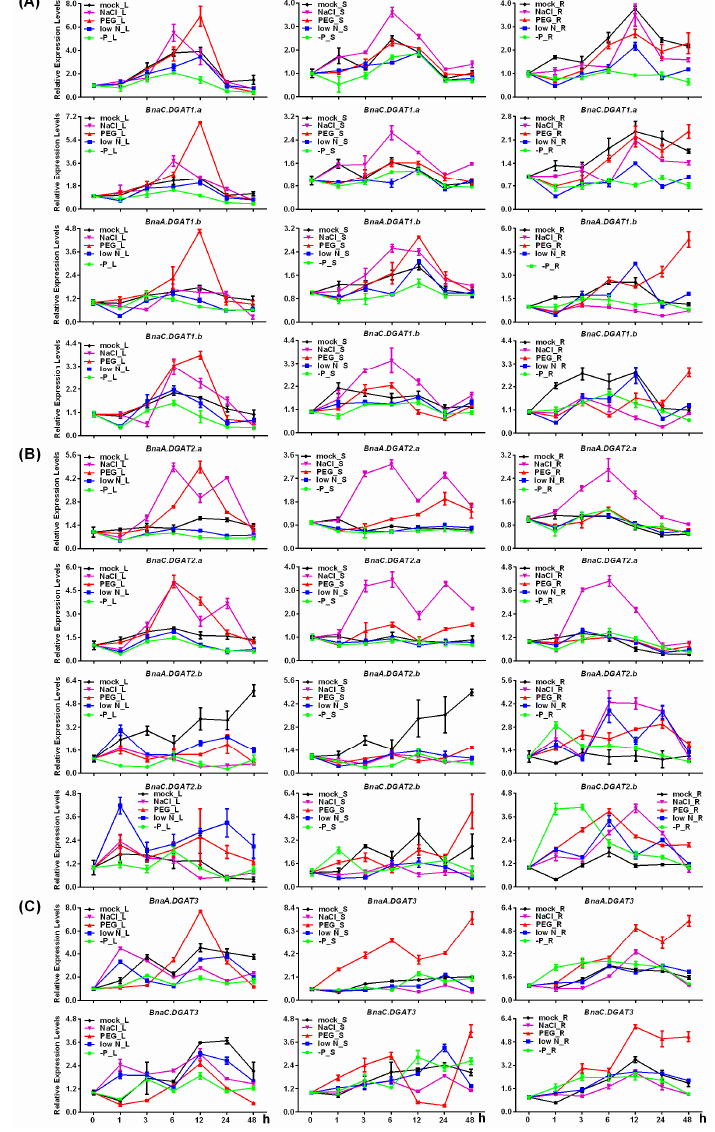
Figure 7. qRT–PCR analyses of different BnaDGATs under different stresses. ( A ) qRT–PCR analyses of BnaDGAT1s under different stresses; ( B ) qRT–PCR analyses of BnaDGAT2s under different stresses; ( C ) qRT–PCR analyses of BnaDGAT3s under different stresses. For dehydration and salt